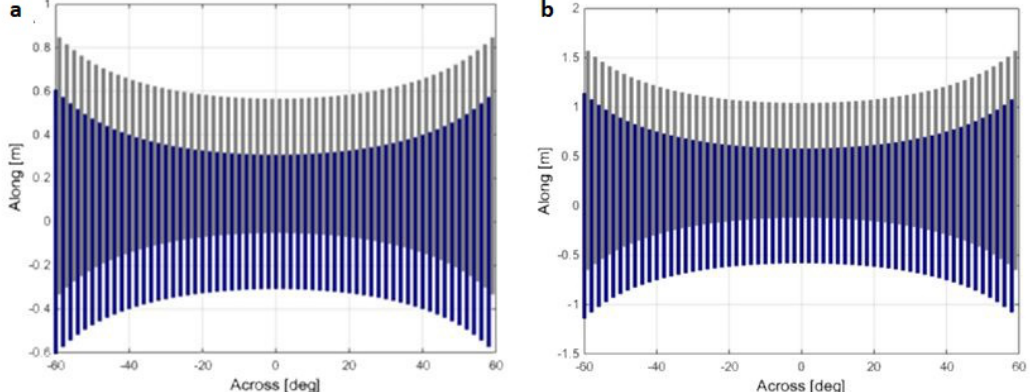
Figure 23. TX footprint for two swaths (Single swath mode): ( a ) 40 m altitude; and ( b ) 75 m altitude. EM 304